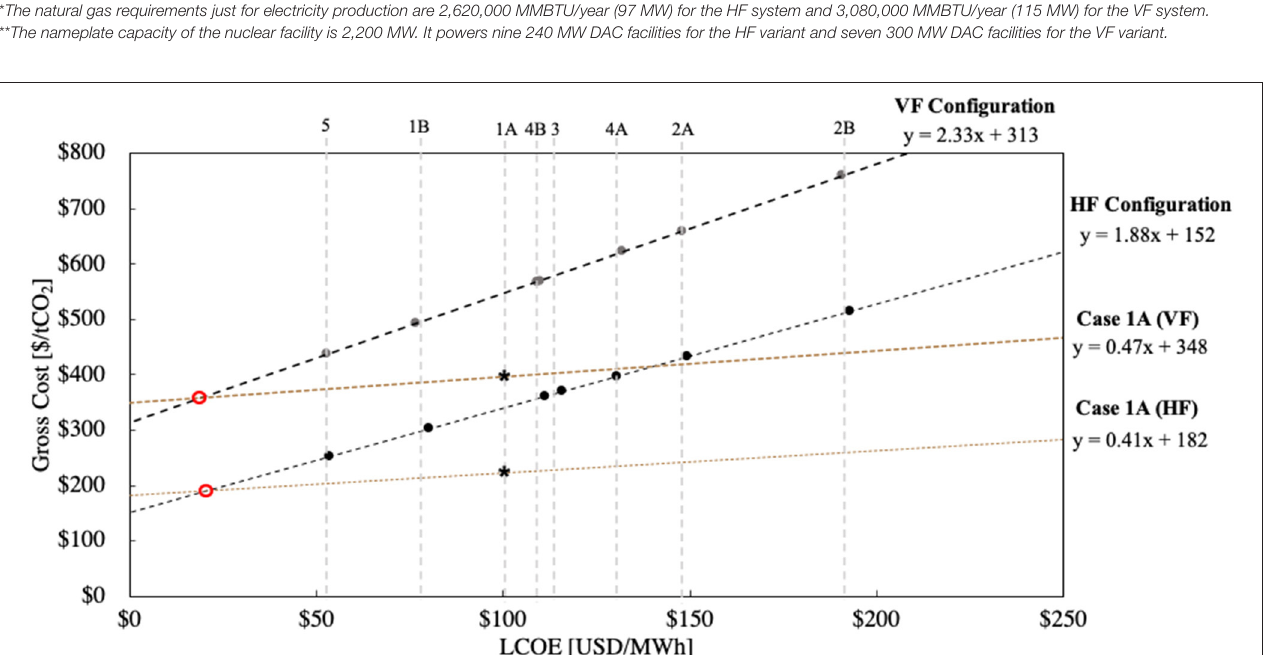
common value for this parameter is used for all cases. In the next section we perform sensitivity analyses on these three